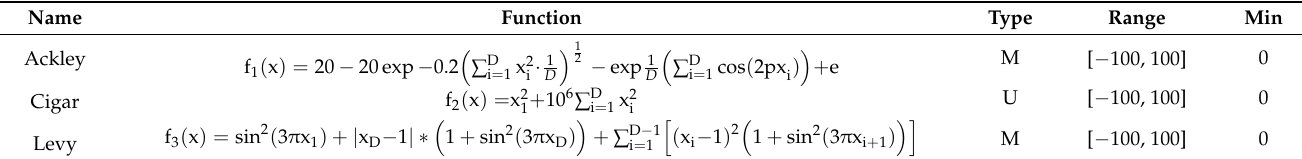
Table 2. Classical test problems.